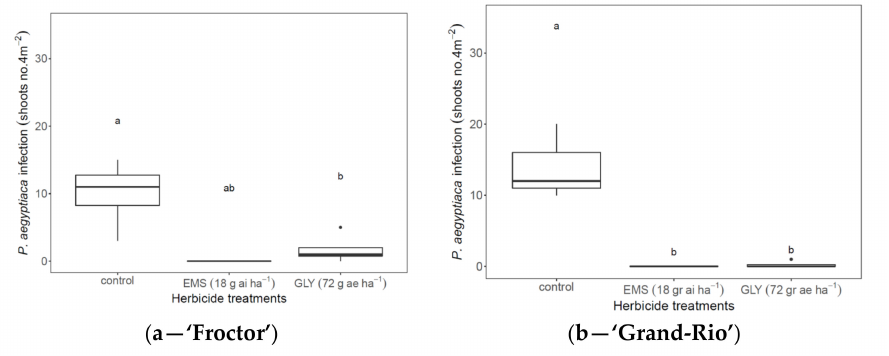
Figure 6. In P. aegyptiaca -infested fields, cabbage cultivars ‘Froctor’ ( a ) and ‘Grand-Rio’ ( b ) were treated with three sequential foliar applications of ethametsulfuron-methyl (EMS) or glyphosate (GLY) 21, 35, and 49 DAP at the doses of 72 g ae ha − 1 glyphosate and 18 g ai ha − 1 EMS, followed by water spraying after each herbicide eight hours after herbicide application. Means were compared using GLM ( p < 0.05); means that are indicated with the same letter do not show significant